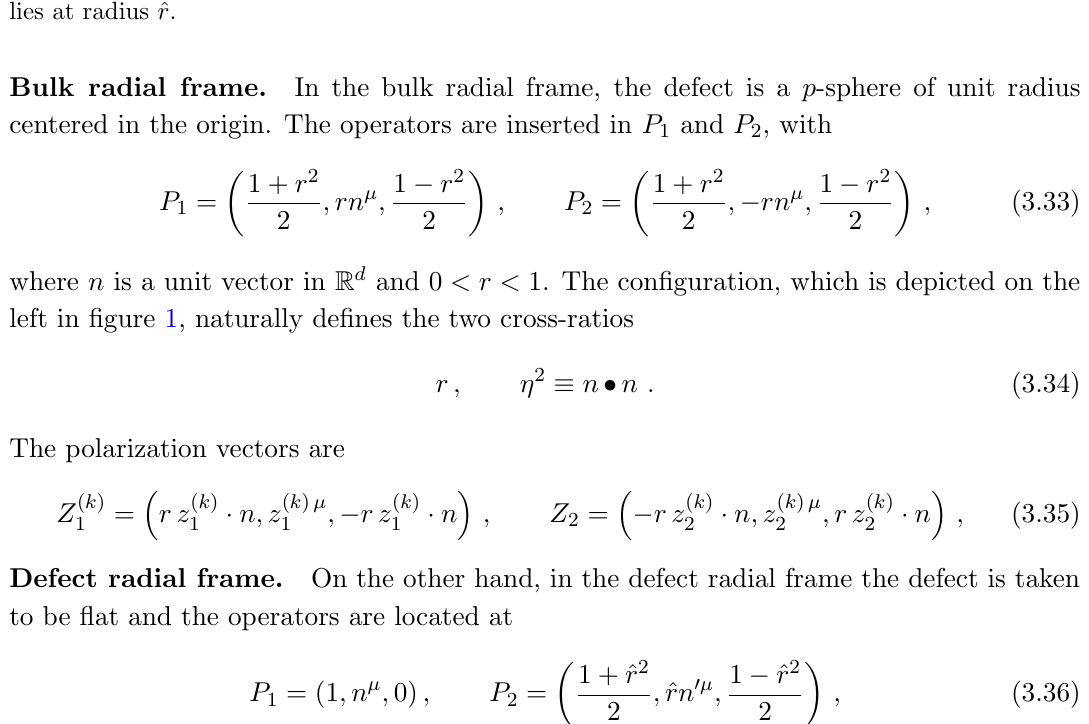
and sit at the same radius O 1 O 2 sits at unit radius, while O 1 O 2